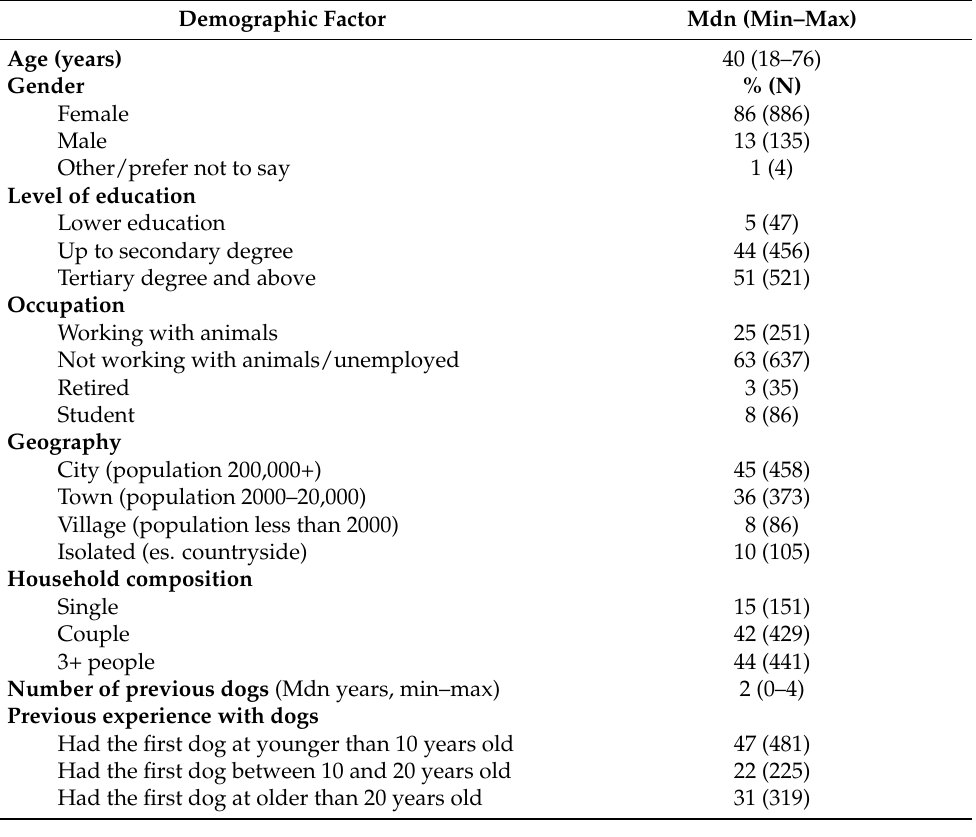
Table 2. Demographic information of the